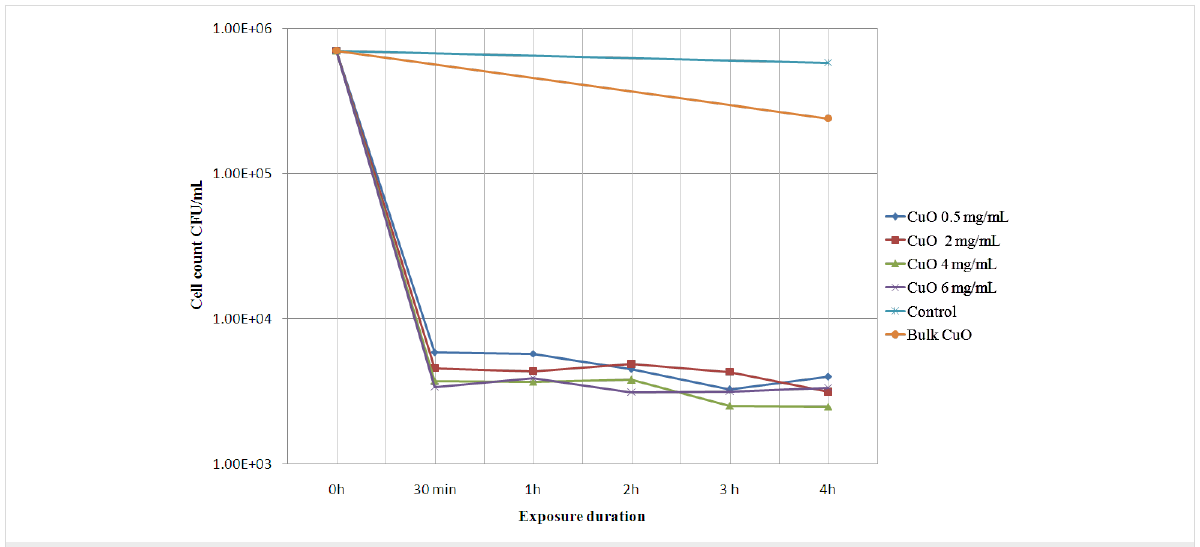
Figure 4: Dose and time dependent bactericidal activity of CuO multi-armed nanoparticles (P5) against B. anthracis vegetative cells in saline media compared with bactericidal activity of bulk CuO (commercial).